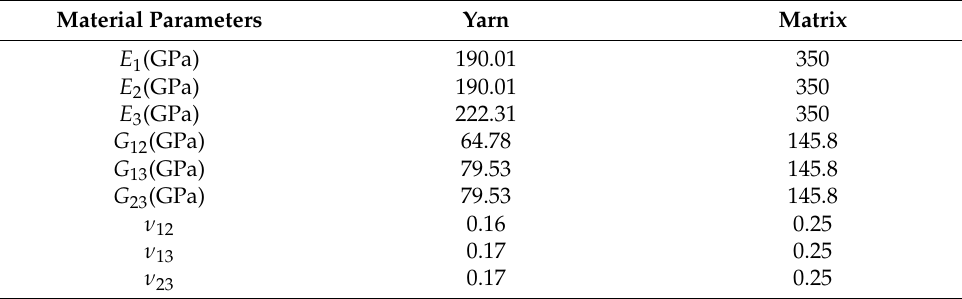
Table 2. Material parameters of 2D SiC/SiC CMCs.